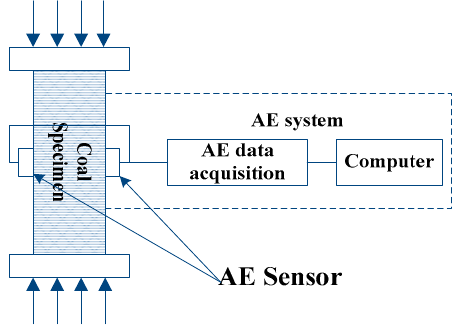
Figure 2. Schematic diagram of acoustic emission (AE) test system in laboratory.